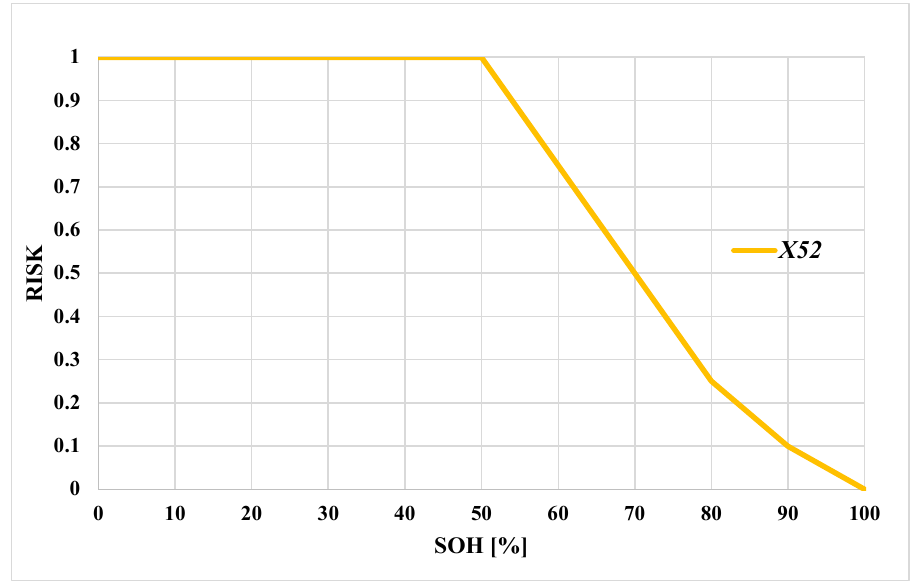
Figure 5. Relation between SOH and risk value.